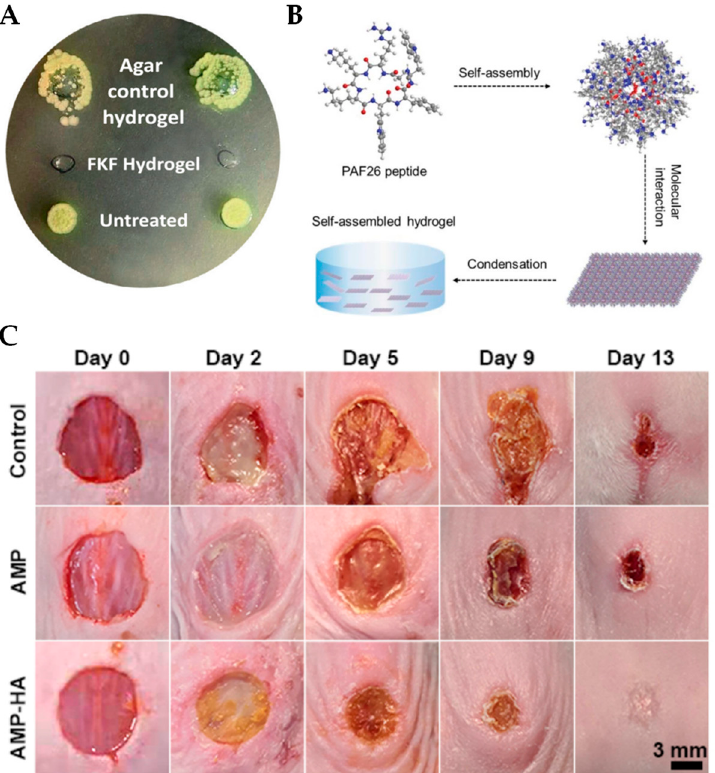
Figure 2. Self-polymerizing hydrogels are effective antimicrobial agents that can promote wound- healing. ( A ) P. aeruginosa spotted on an agar plate shows complete inhibition by the FKF hydrogel (center) compared to agar control hydrogels (top) and the untreated positive control (bottom). Reprinted with permission from Ref. [82]. Copyright 2021, Elsevier. ( B ) The proposed self-assembly mechanism of the PAF26 peptide. When the pH of the solution reached 7.5, the molecular stacking interactions lead to the formation of β -sheet structures that self-assemble into micelles. The micelles then are linked together into a chain-like structure, which, following condensation, leads to the formation of a hydrogel. Reprinted with permission from Ref. [89] Copyright 2019, The Royal Society of Chemistry. ( C ) In vivo wound-closure studies from S. aureus -infected mice wounds. Wounds were evaluated on days 0, 2, 5, 9, and 13 post-infection. The control group was untreated, while the AMP group was treated with soluble AMP, and the AMP-HA cohort was treated with AMP-loaded hydrogels. Reprinted with permission from Ref. [94]. Copyright 2021, American Chemical Society.